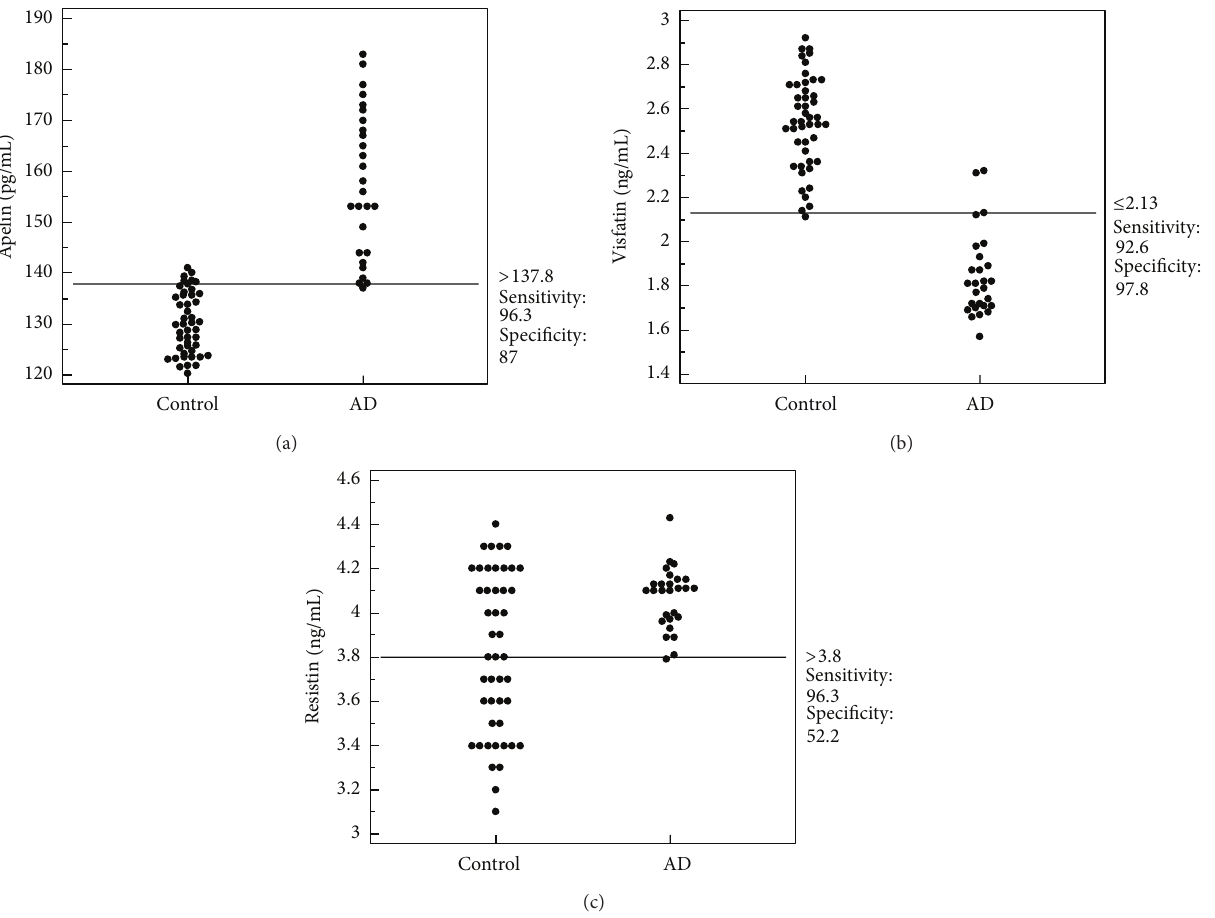
Figure 1: Interactive dot diagram comparing levels of (a) apelin, (b) visfatin, and (c) resistin levels between children with atopic dermatitis and healthy